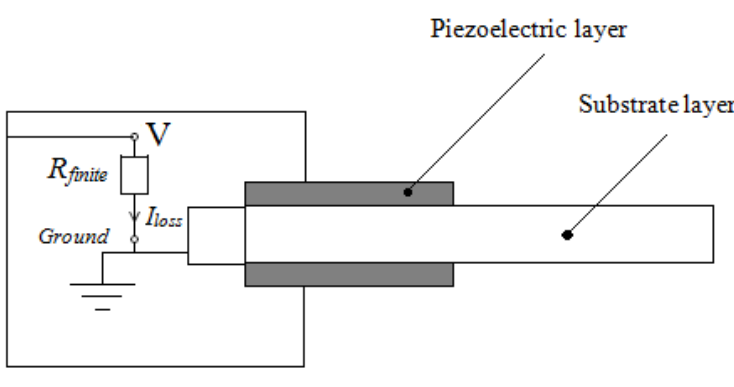
Figure 11. Equivalent circuit and the current